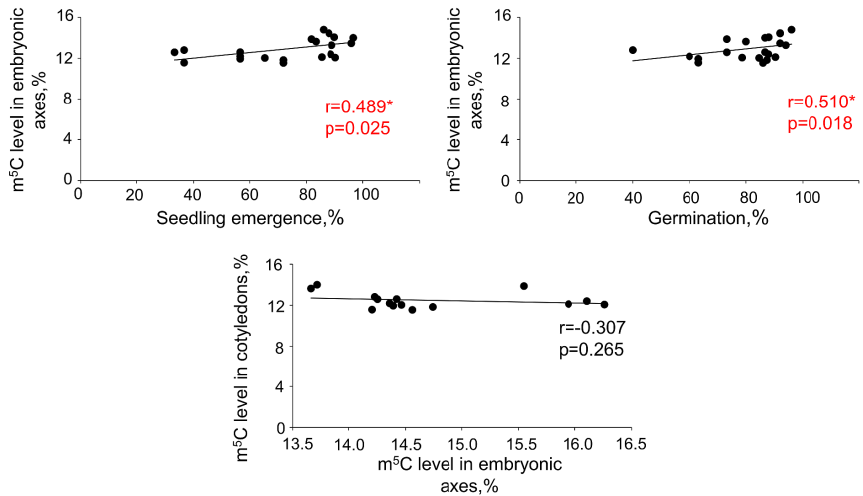
Figure 3. Spearman correlation coefficient (r) between seedling emergence and global DNA meth- ylation level in embryonic axes, germination capacity and global DNA methylation level in embry- onic axes, and global DNA methylation level in embryonic axes and cotyledons. Values marked with * are significantly different at p < 0.05 and have been additionally marked in red.